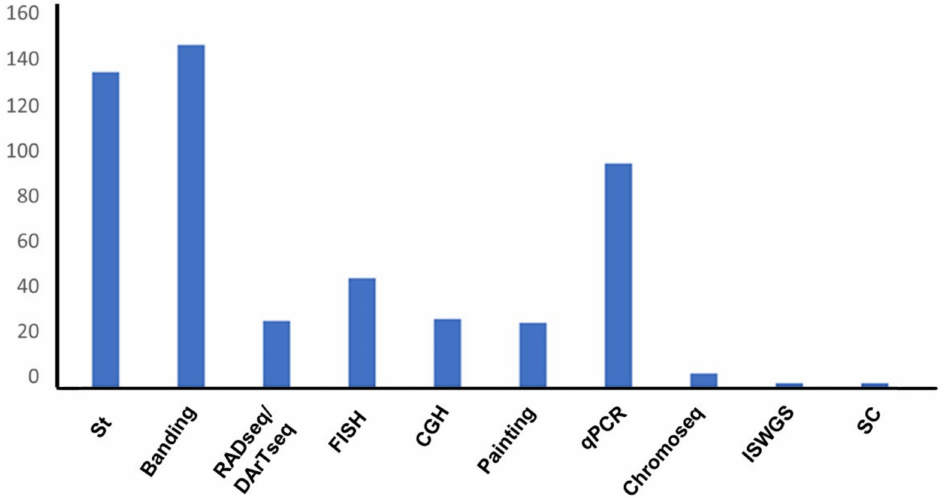
Figure 5. Experimental methods employed in the study of lizard sex chromosome systems; st = standard karyotyping; banding = banding techniques (C- and G-banding); painting = chro- mosome painting; ChromSeq = single-chromosome sequencing; ISWGS = in silico whole genome subtraction; SC = Synaptenemal